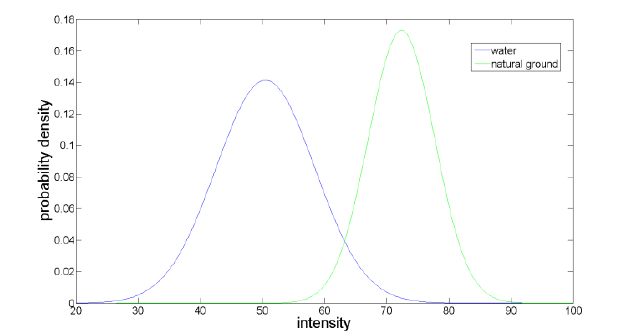
Figure 3: Probability density functions of feature